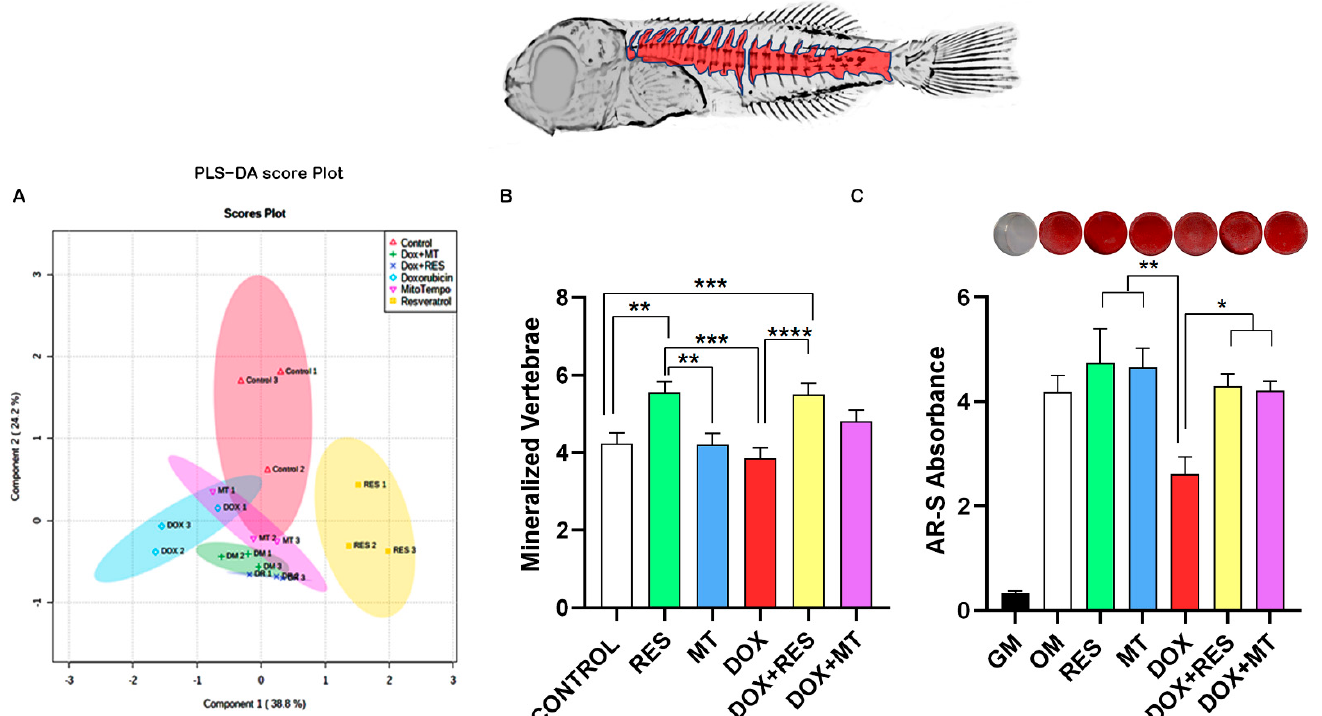
Figure 5. Mineralization of the skeletal elements. Partial Least-Squares Discriminant Analysis (PLS-DA score) between the antioxidants and pro-oxidants groups on the mineralization of the skeleton elements ( A ), Mineralized vertebrae of seabream fed with Microdiets ( B ), and Extracellular matrix mineralization assay of Vsa13 cells ( C ). One-way ANOVA, Tukey’s multiple comparisons test, *— p ≤ 0.05, **— p ≤ 0.01, ***— p ≤ 0.001, and ****— p ≤ 0.0001. Acronyms: Alizarin red-S (AR-S), Growth medium (GM), Osteogenic medium (OM), resveratrol (RES), doxorubicin (DOX), MitoTEMPO (MT), doxorubicin + resveratrol (DOX+RES), and doxorubicin + MitoTEMPO (DOX+MT).